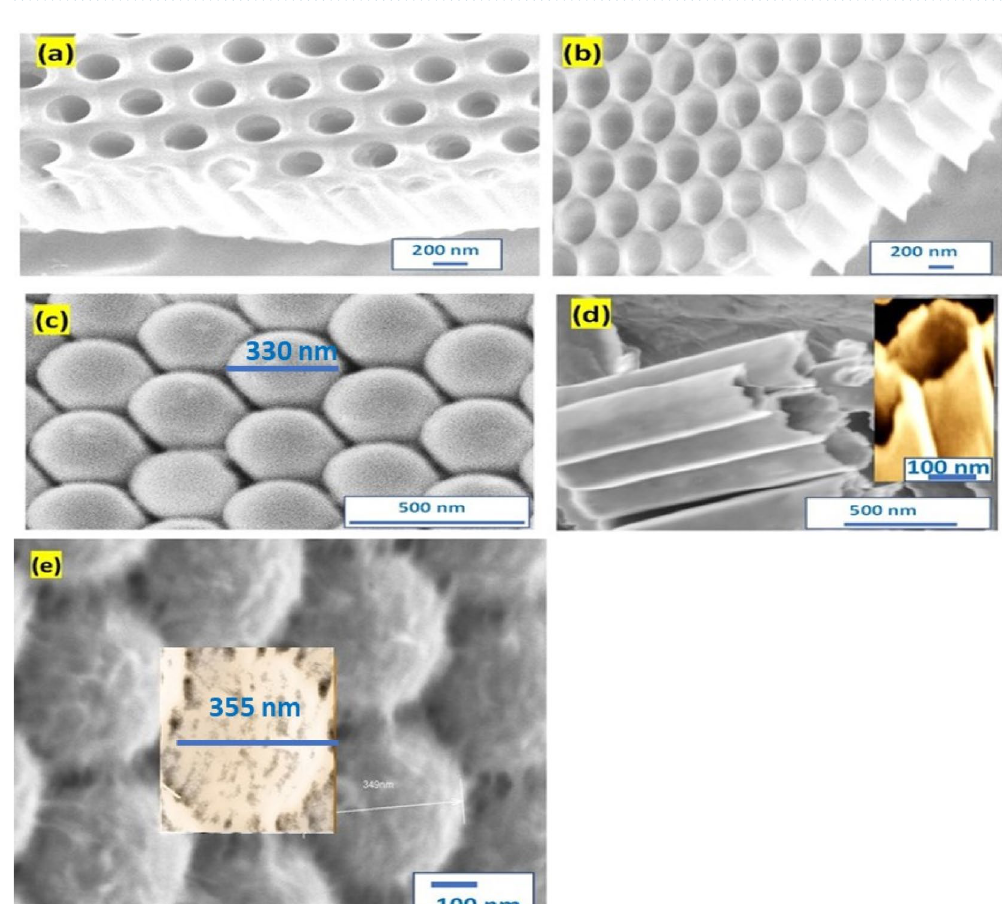
Figure 2. The SEM of Al 2 O 3 template after pore widening for ( a ) 10 and ( b ) 30 min at 60 °C. ( c ) Bottom image ( d ) cross-section image of the TiO 2 /TiN hollow tubes after removing PAOT. ( e ) TiO 2 /TiN (bottom